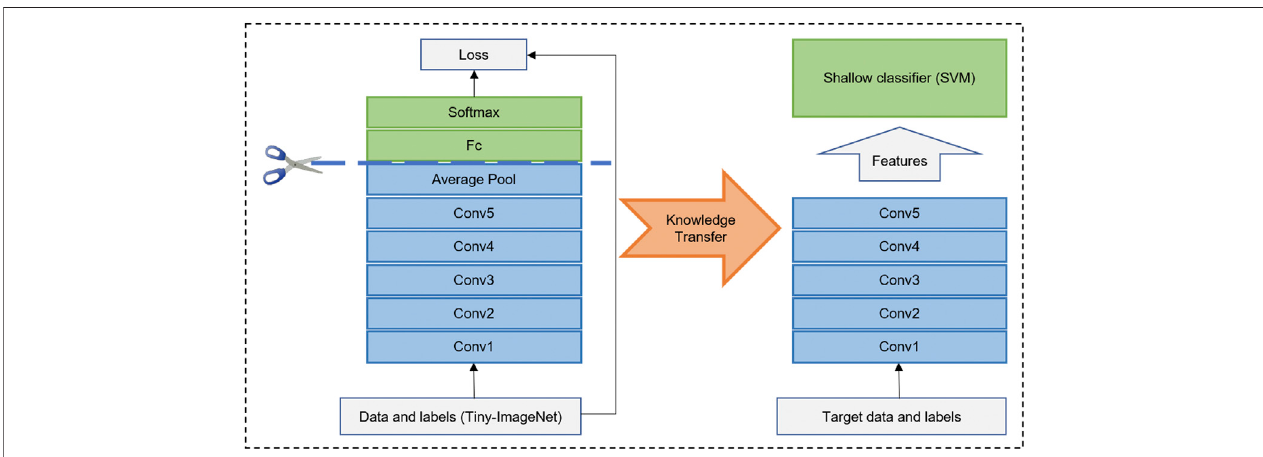
FIGURE 2 | Illustration of deep residual network (DRN) as feature extraction and transfer. DRN was pretrained on Tiny-ImageNet dataset. Then, backbone ofwell- trainedDRNwastransferredondifferentmodalityimagesforfeatureextraction.Intheend,featurecanbeputintoafullconnectionlayerorshallowclassi fi er(i.e.,Support Vector Machine,